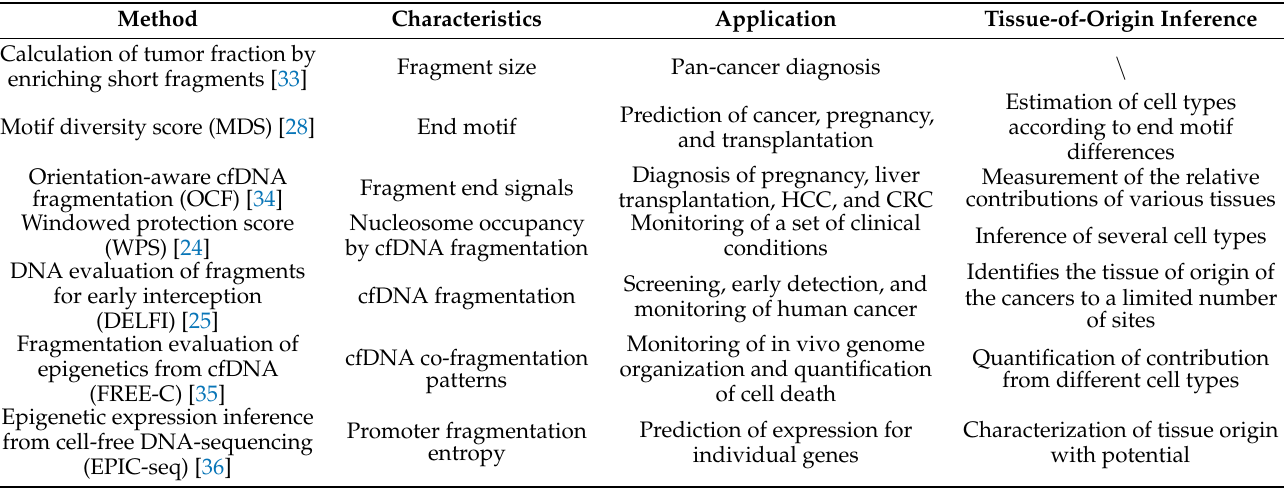
Table 1. Summary of important cfDNA fragmentomics methods.